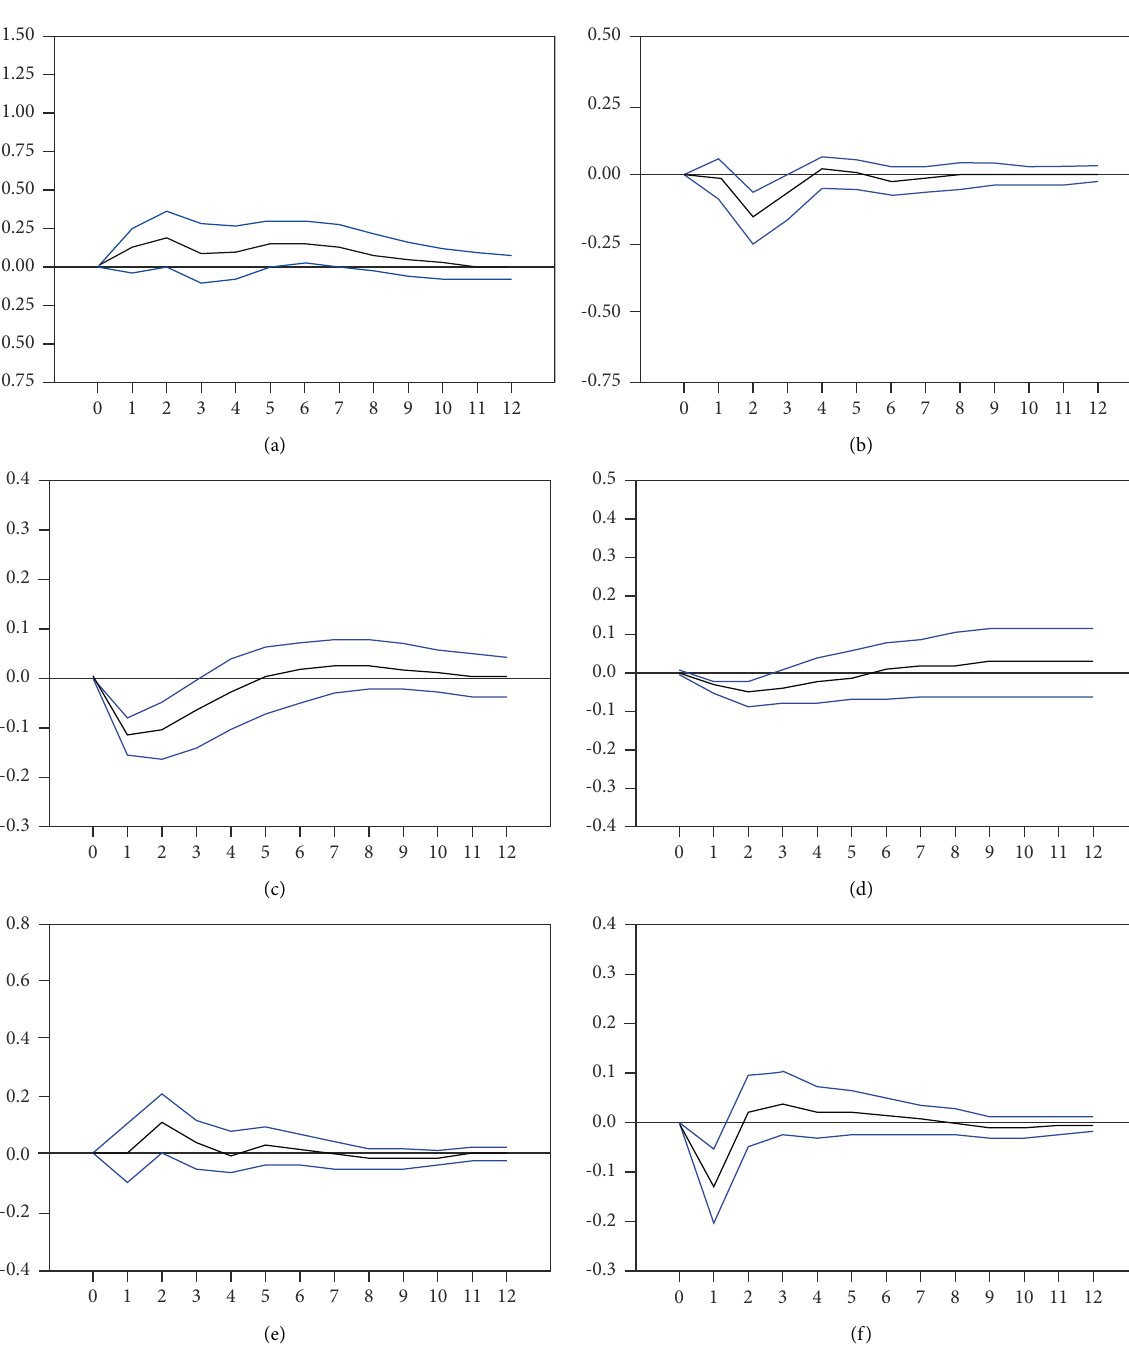
Figure 4: IRF of the seaborne freight volume based on the alternative aggregation. (a) Foreign real economic shocks. (b) Foreign infation shocks. (c) Foreign liquidity shocks. (d) Foreign rates shocks. (e) Domestic GDP shocks. (f) Import-export trade volume shocks. Note: the blue line represents the 90% confdence interval. Te unit of the vertical line is %